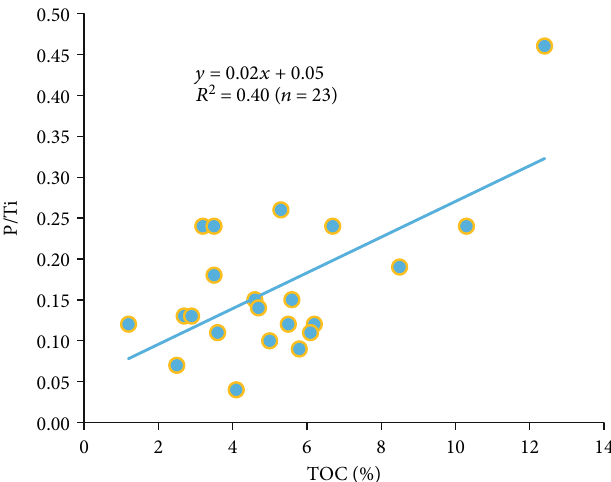
Figure 6: Crossplots of TOC content versus paleoproductivity proxies (P/Ti) of the samples in the Taiyuan and Shanxi